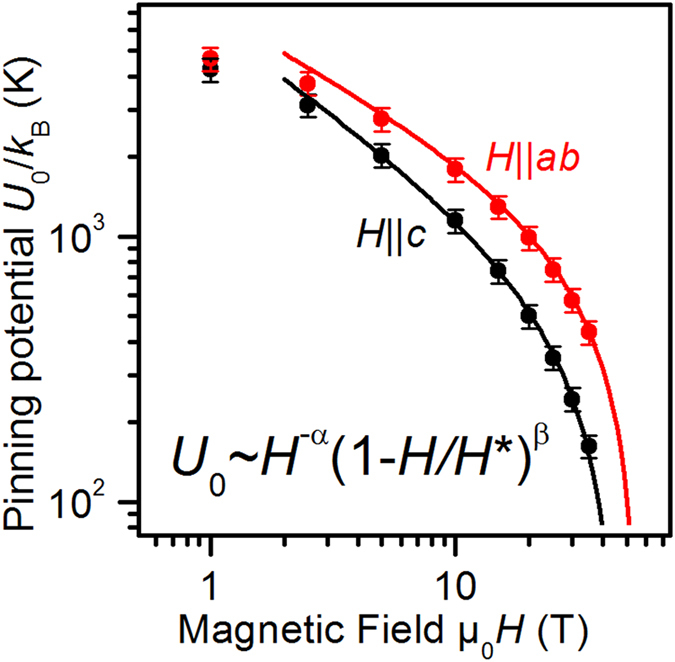
Magnetic field dependence of the pinning potentialU0. Full lines are fits to Eq. 3 for H ≥ 5 T.